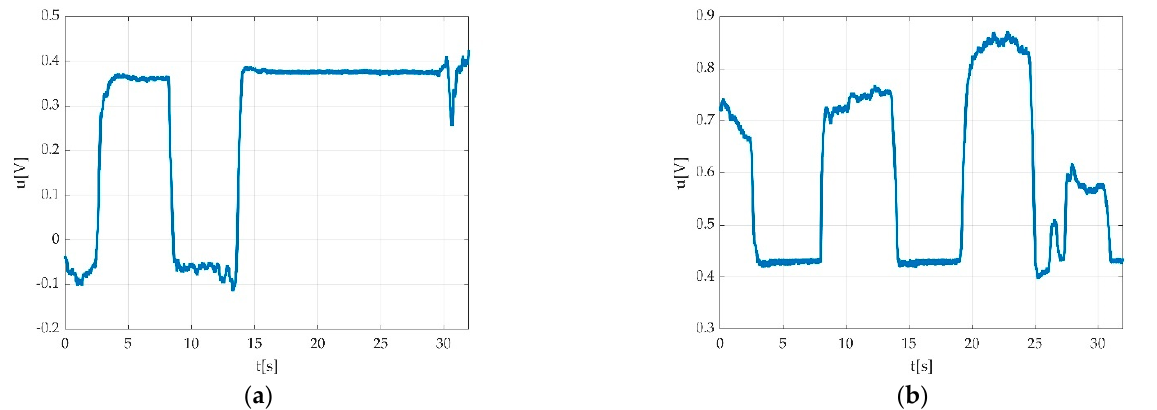
Figure 18. Example of errors due participant delay in contractions the muscle on tester command: